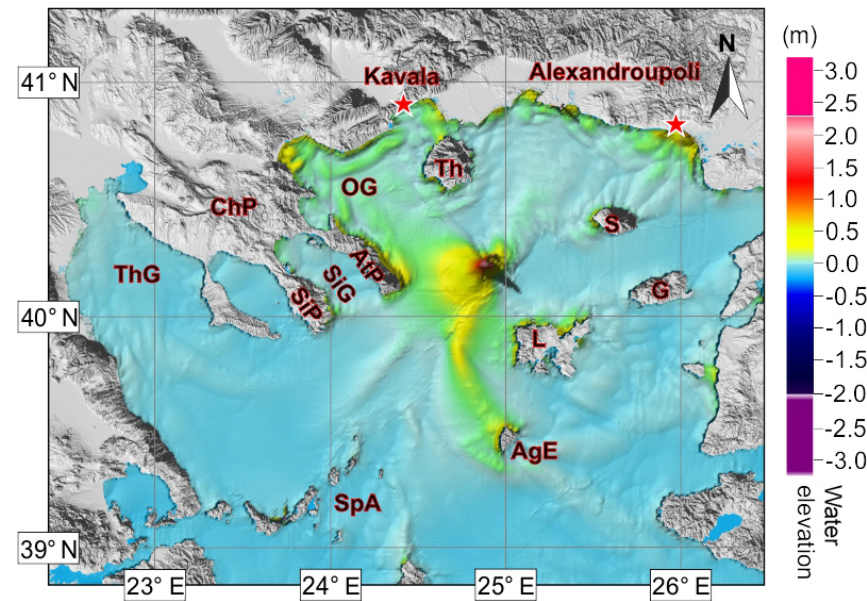
Figure 8. Maximum water elevation of the tsunami for the second credible scenario (Table 1). AgE is Agios Efstratios, AtP is Athos peninsula, G is Gokceada, L is Lemnos, OG is Gulf of Orfani, S is Samothrace, SiG is Sigitikos Gulf, SiP is Sithonia peninsula, SpA is Sporades archipelago, Th is Thasos and ThG is Thermaic